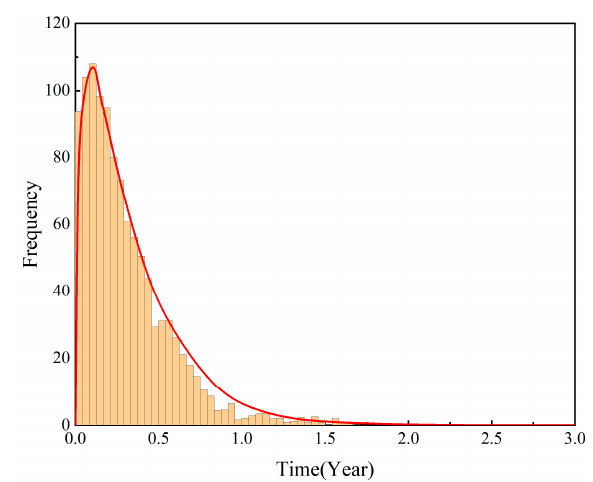
Figure 7. Histogram of bearing failure time